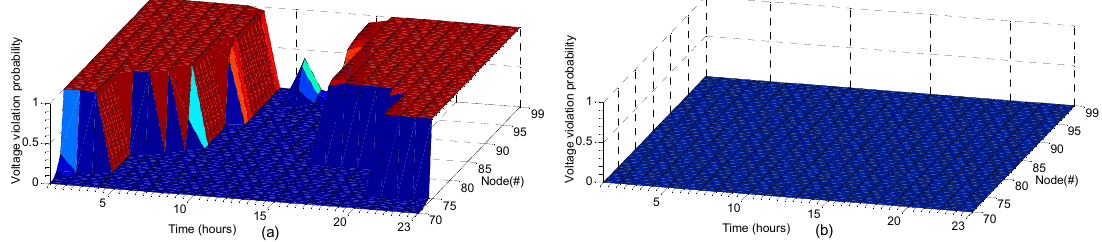
Figure 11. Voltage violation probability, based on regulations, for nodes 70 to 99 during a working day in July. ( a ) scenario #2; ( b ) scenarios #4 and #6.